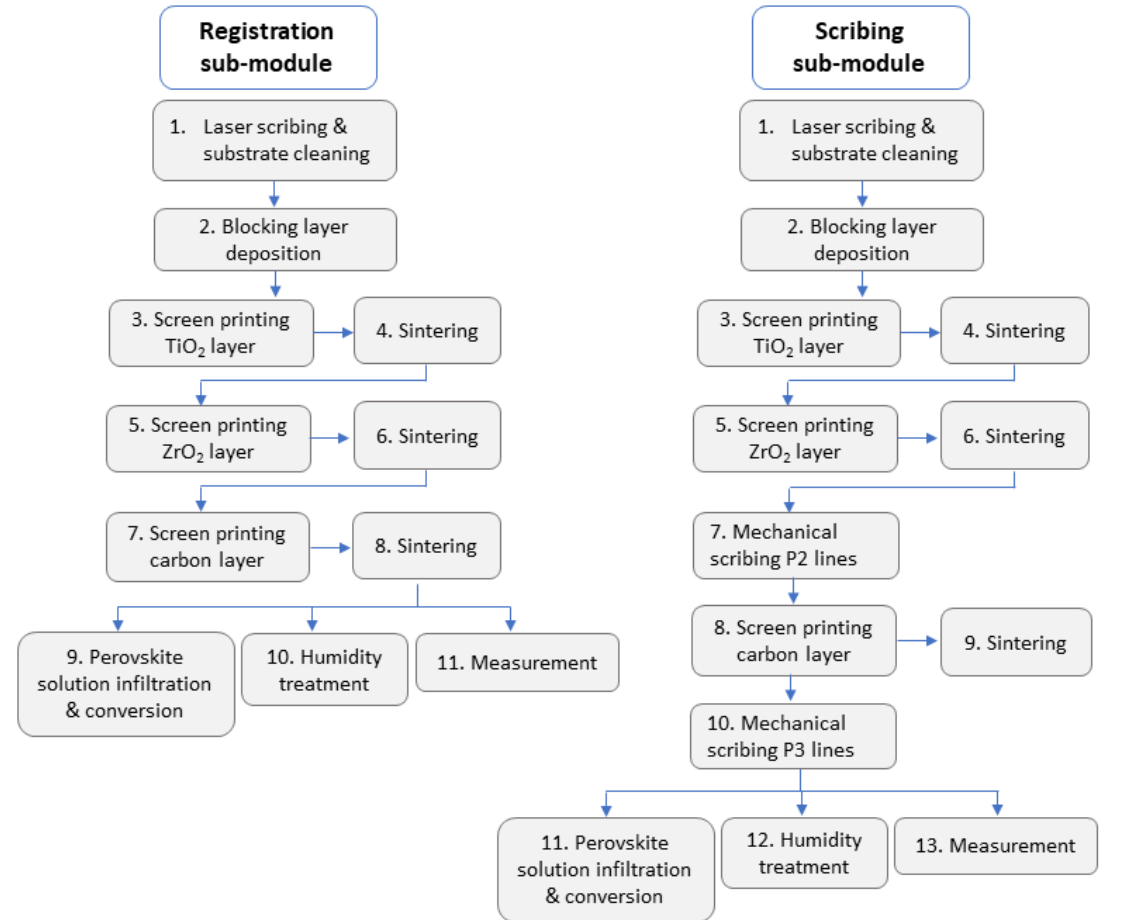
Figure 1. Fabrication steps for R and S sub-modules.